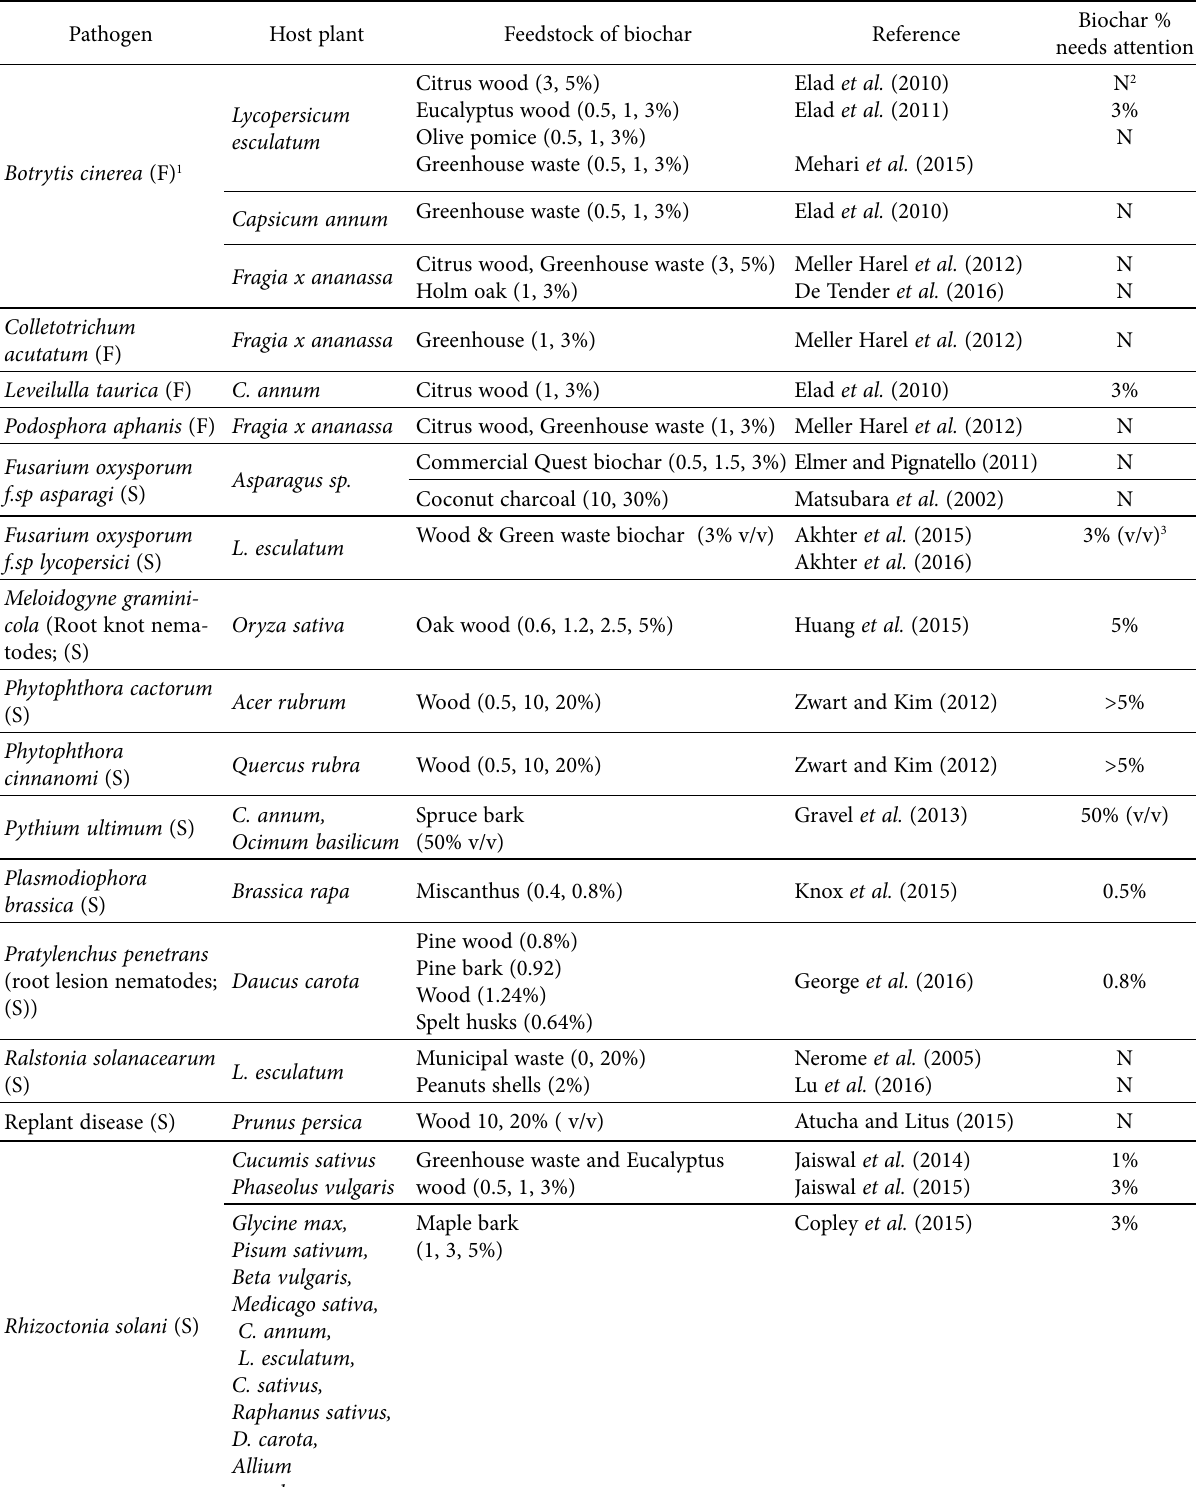
Table 2. List of the studies that tested biochar in growth media on soilborne and foliar plant diseases. The last column gives the biochar concentration which exhibits negative influence on plant health compared with the control (no biochar) or compared with the biochar concentration having the most positive effect on disease suppression treatment, therefore representing the phenomena of the U-shape dose